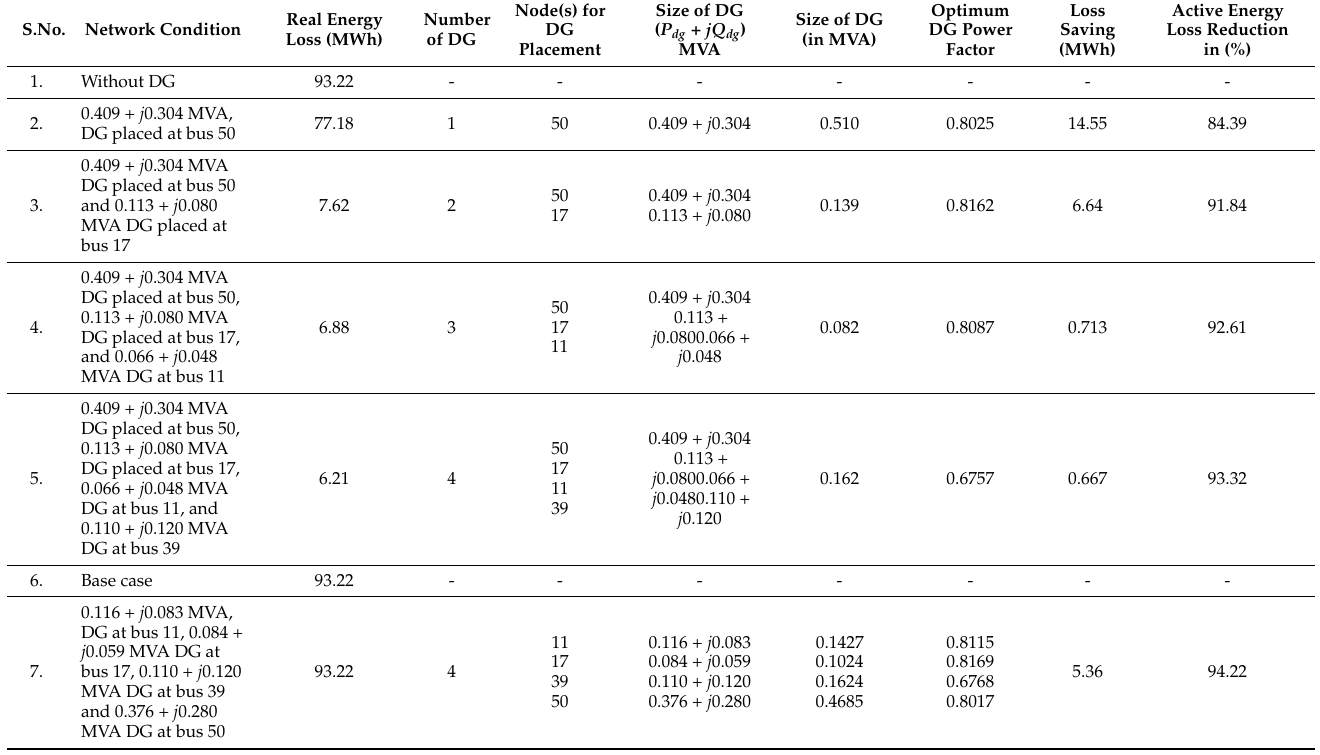
Table A2. Summary of the simulation results for IEEE 69-bus radial distribution network.